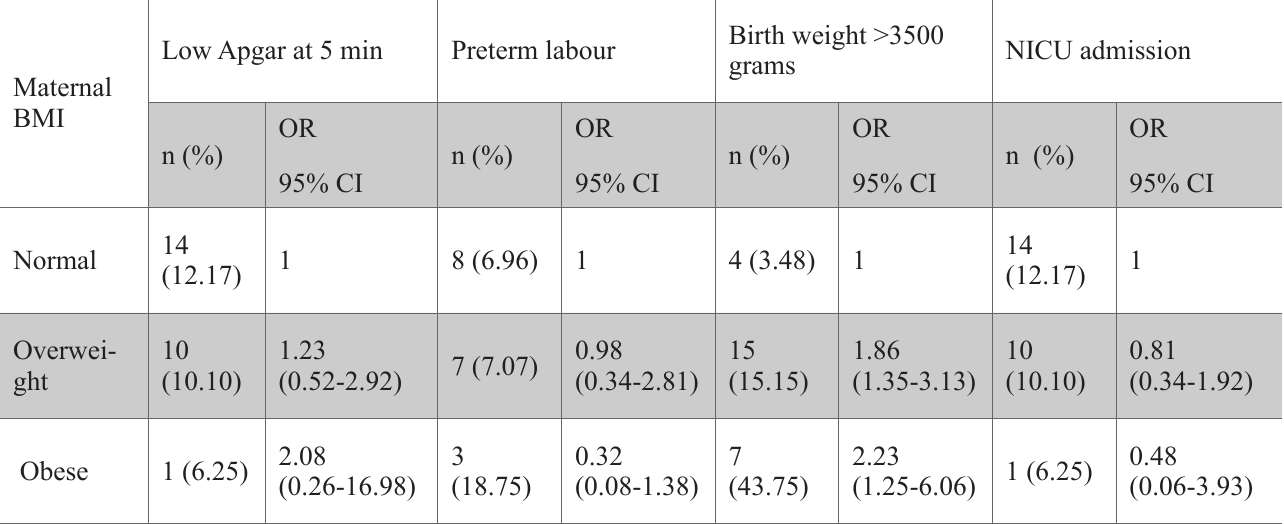
Table 3: Comparison of neonatal outcomes among the study and reference groups